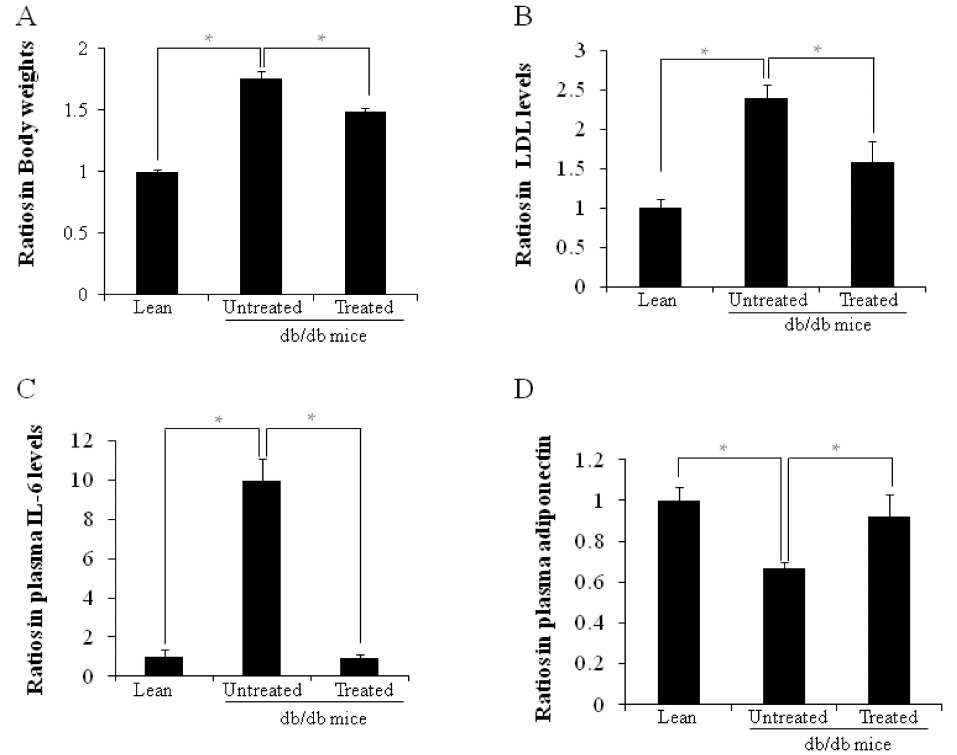
Figure 1. A – D Ratios of body weight, plasma LDL, IL-6 and adiponectin levels. ( A ) Ratios of body weights are shown (* p < 0.05); ( B ) Plasma LDL levels (* p < 0.05); ( C ) Plasma IL-6 levels (* p < 0.05); ( D ) Plasma adiponectin levels (* p < 0.05). The results are mean ˘ SD, n = 6 in each